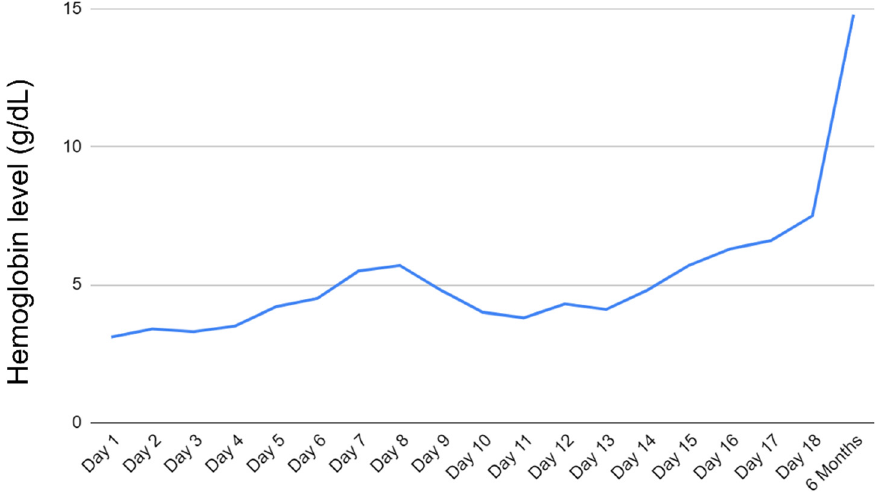
Figure 1. The trend and improvement of hemoglobin at pre- and post-treatment .